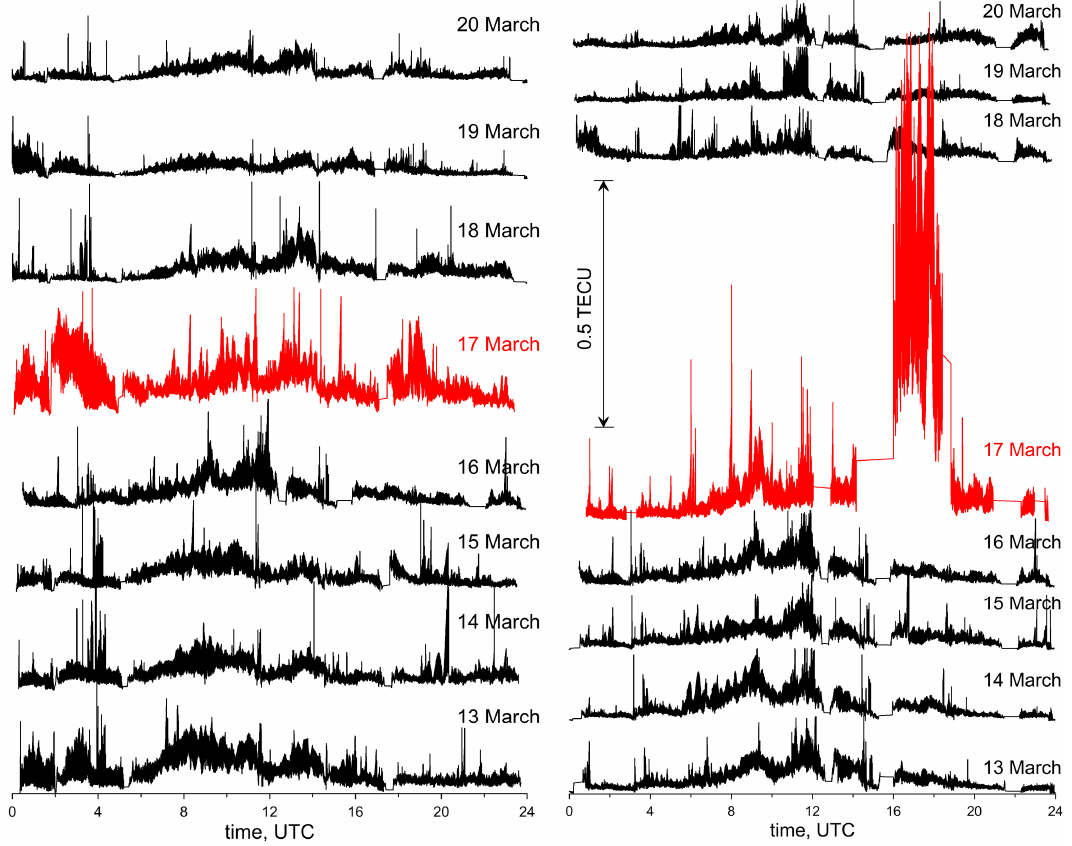
Figure 5. RMS of TEC variations in diurnal cycles: year 2013 ( left ) and 2015 ( right ).